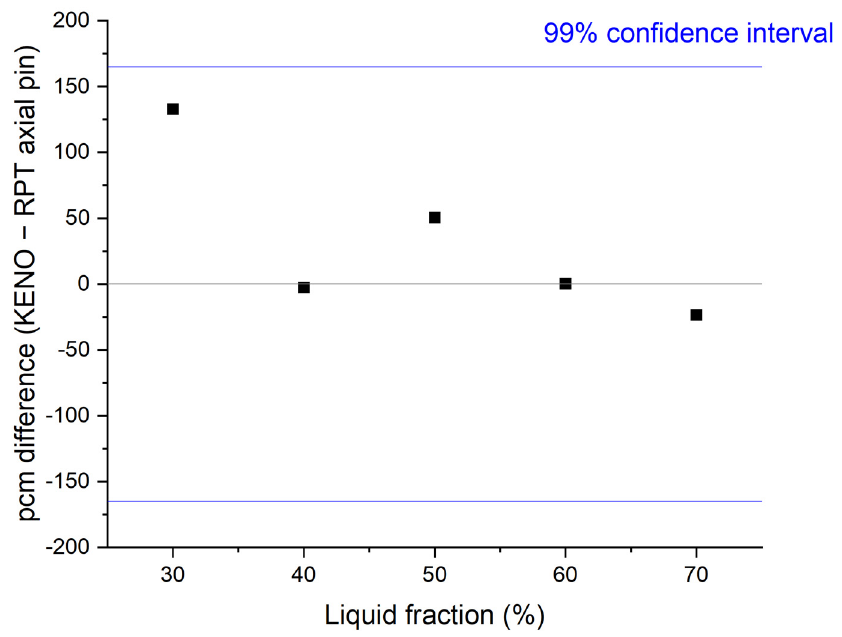
Figure 18. Difference in pcm units between the k-eff values of the 3D SCALE KENO and an equivalent axial pin model modified by the given fuel width modification factor. In this case, a seed and blanket geometry of 50 cm regions and a void fraction of 50% is used to calibrate the RPT. The results show that, firstly and most importantly, axial heterogeneity can be successfully modelled by the RPT method in 2D, and that the method is relatively robust against requiring recalibration for changes in water density.